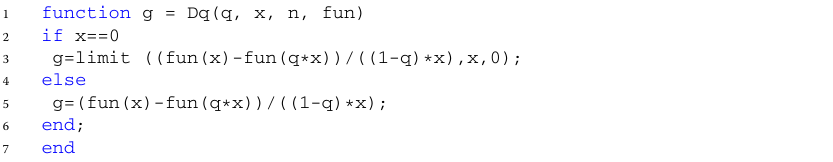
Algorithm 3 The proposed method for calculated ( D q f )( x